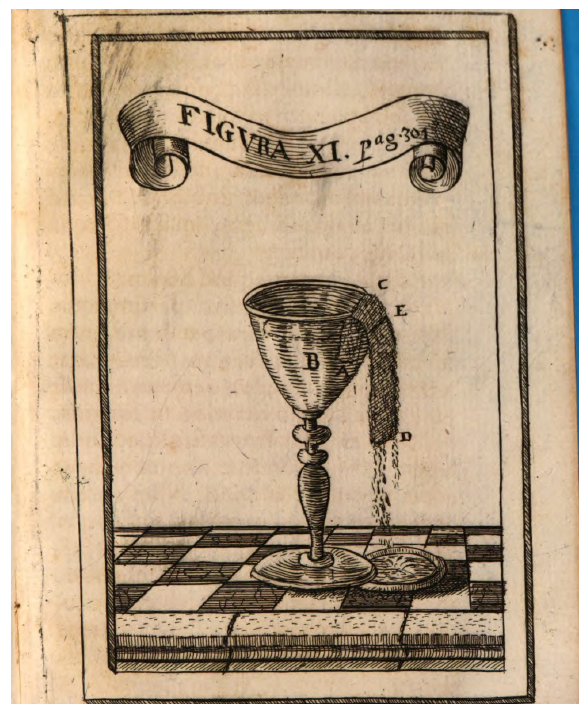
Figure 4. Figure XI from Schott’s opus Anatomia physico– hydrostatica fontium ac fluminum (Schott, 1663, credits: Bay- erische Staatsbibliothek München, Phys.sp. 604 b, sheet 355,